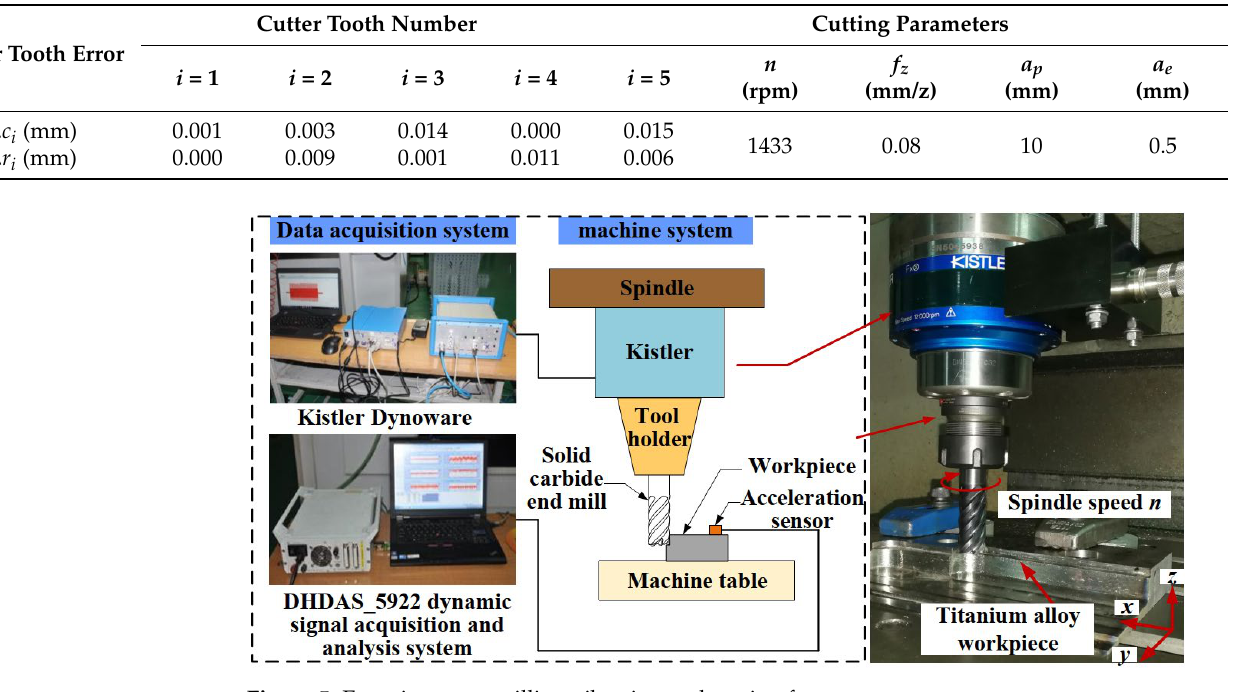
Table 1. Milling scheme and cutter tooth error distribution.